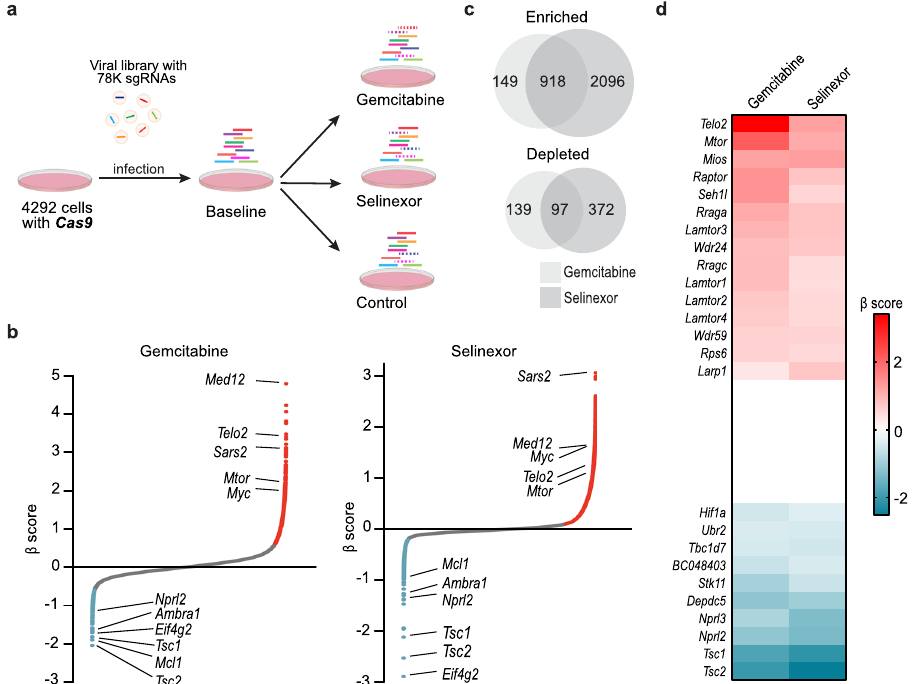
Fig. 1 | Genome-wide CRISPR screening identi fi es the mTOR pathway as a determinant of chemosensitivity. a CRISPR knockout screens in 4292 cells. DashedbarsindicatedepletedsgRNAs. b Generankingbasedon β scoresinthetwo screens. Representative top enriched or depleted genes were labeled on the plots. Redand blueindicate signi fi cantgene enrichmentordepletion with p <0.05.Two- sided permutation test. False discovery rate (FDR) correction of the p-value